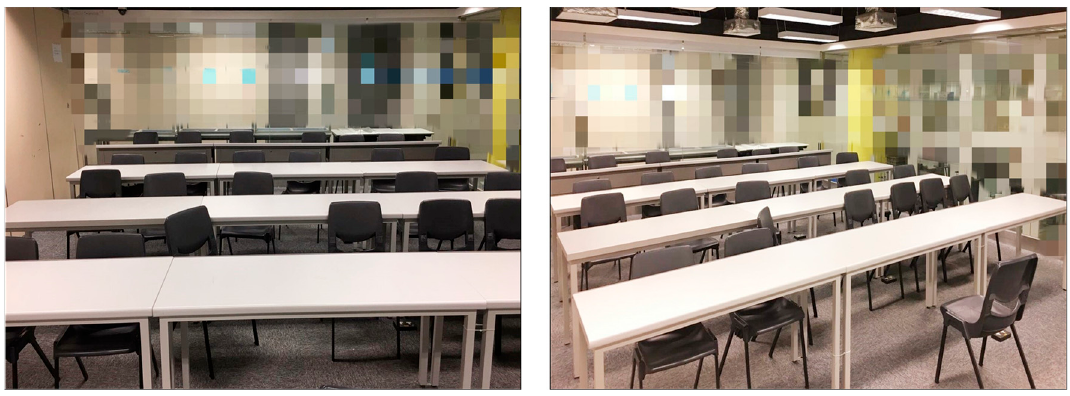
Figure 5. Screenshots of the test room.